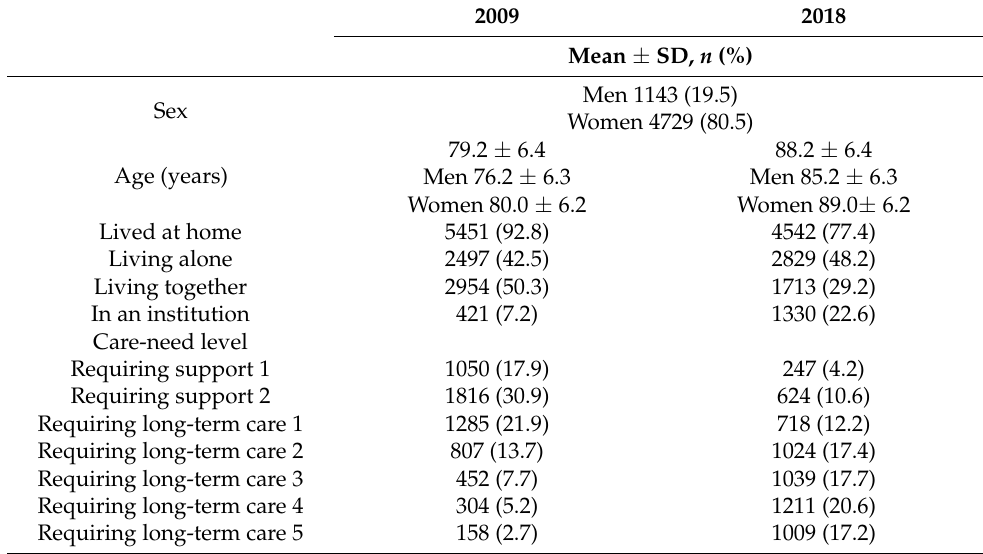
Table 1. Participants’ characteristics ( N =